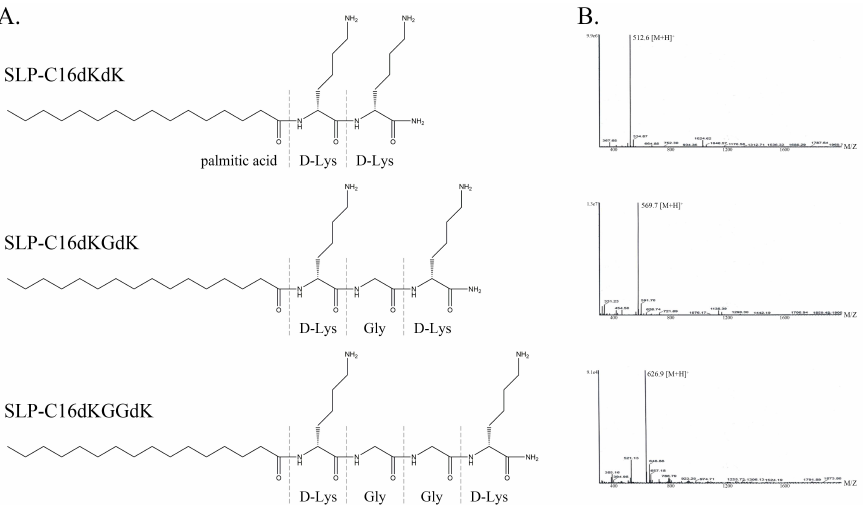
Figure 1. Lipopeptide synthesis. ( A ) Synthetic lipopeptides’ (SLPs’) chemical structures. The peptides are represented by the International Union of Pure and Applied Chemistry (IUPAC) single- character symbols. ( B ) Mass spectra of synthetic